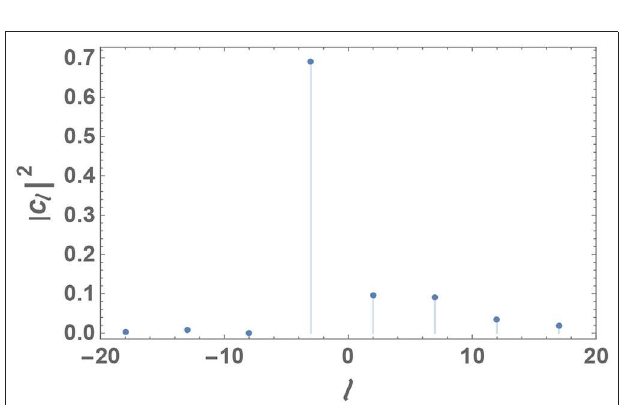
FIGURE 3 | OAM power spectrum arising from the azimuthal phase profile corresponding to the parameter values a n 2 n 3 4 / 3. = =